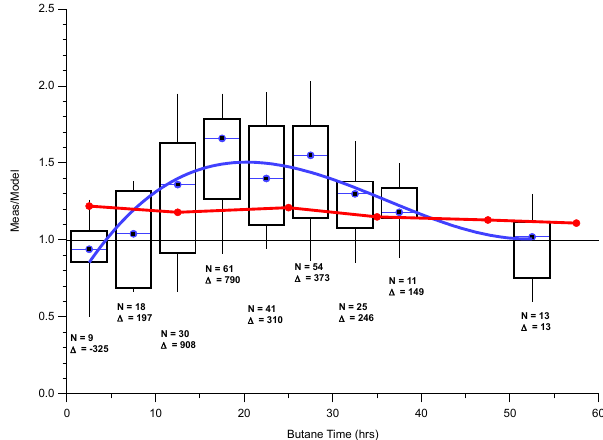
Fig. 14. Box and whisker plot for the TDLAS measurement/model ratio for Mexico City outflow events as a function of the butane time. The boxes denote the interquartile values, the horizontal lines with blue circles are the median ratios and the whisker represent 10 and 90 percentiles values. The blue solid profile is an empiri- cal 4-term polynomial fit of the median Measurement/Box Model ratios to the butane time while the red line with points represents a proxy for this ratio based upon the ratio of Lagrangian-to-steady state predictions (see manuscript for details). The numbers below each whisker plot denote the number of comparisons in that bin (top number) and the median point-by-point measurement-model differ- ences ( 1) in pptv are denoted by the lower